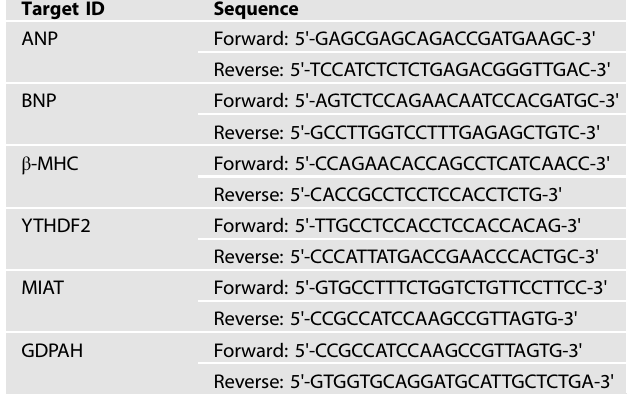
Table 1. Sequences of polymerase chain reaction